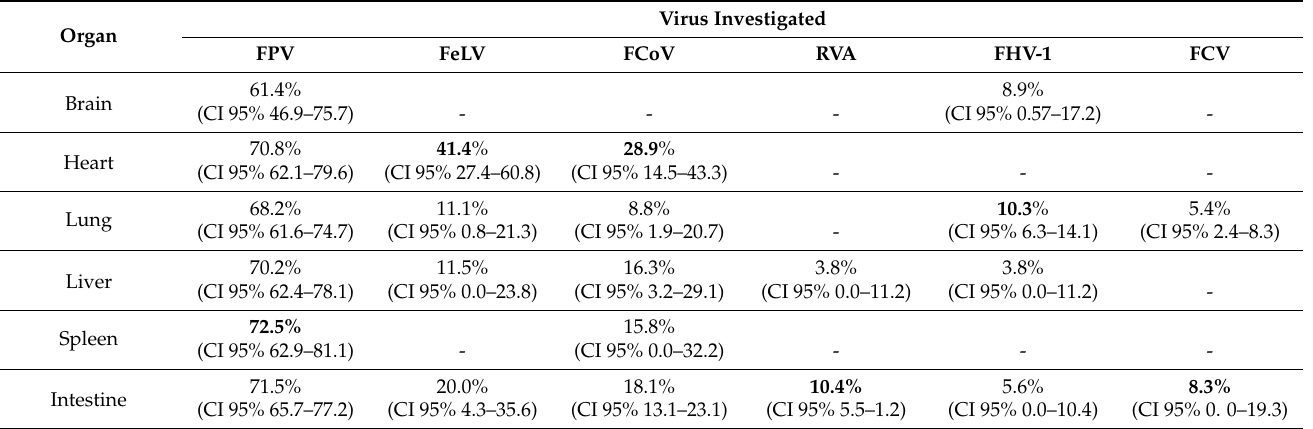
Table 9. Percentage of positive organs with respect to the virus investigated. FPV DNA was prevalently found in the spleen (72.5%), FelV and FCov genomes in the heart (41.4% and 28.9%, respectively), RVA and FCV nucleic acids in the intestine (10.4% and 8.3%, respectively); FHV-1 DNA in the lungs (10.3%). The highest prevalence/virus genomes are in